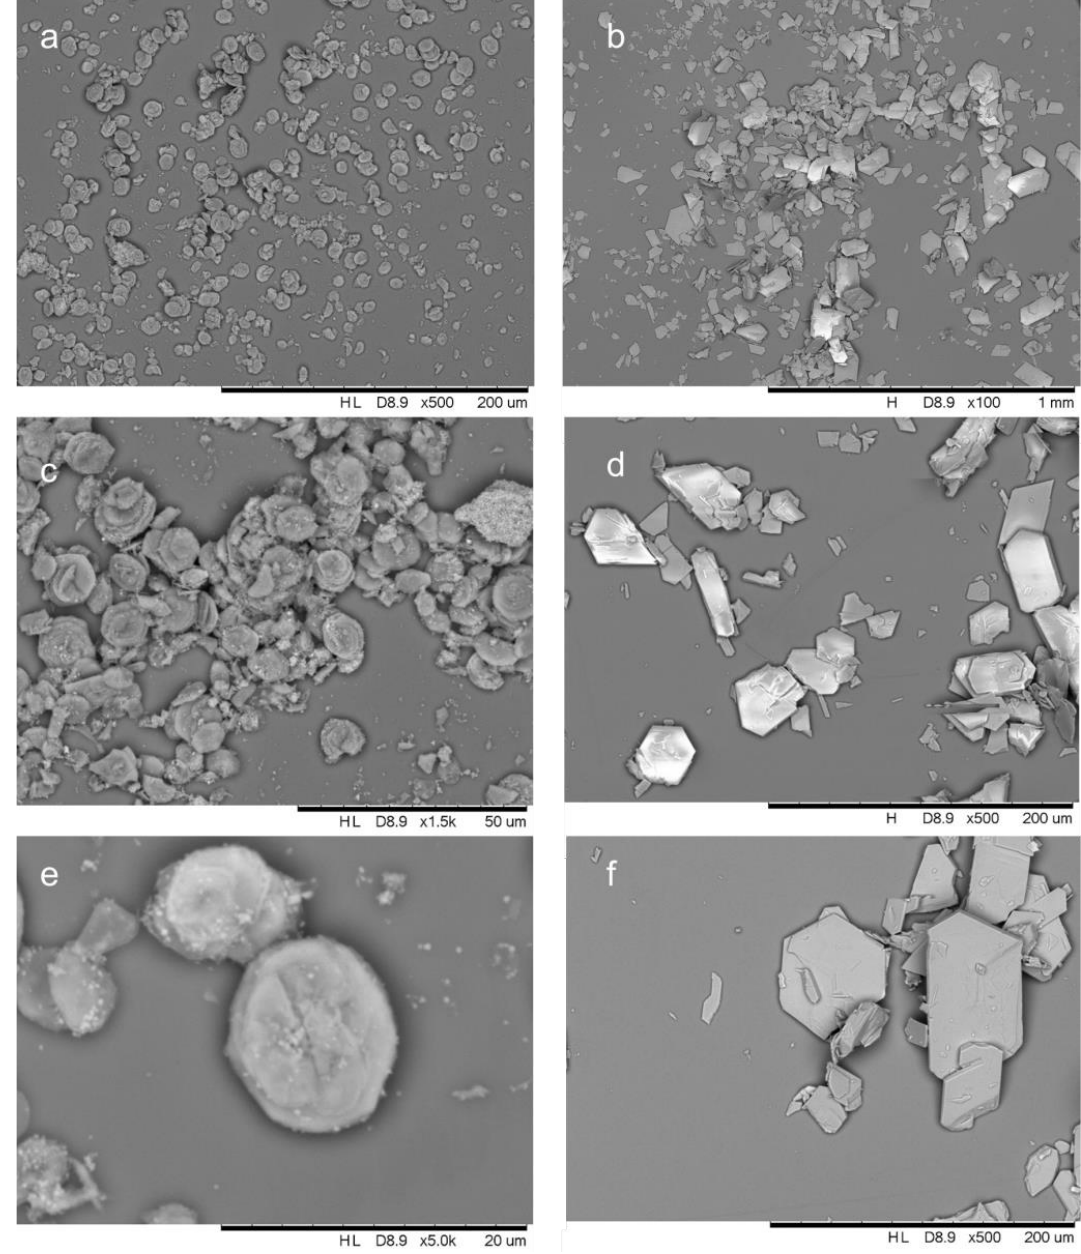
Figure 3. SEM images of ( a , c , e ) copper hydroxy acetate, and ( b , d , f ) copper hydroxy nitrate, in different magnifications.